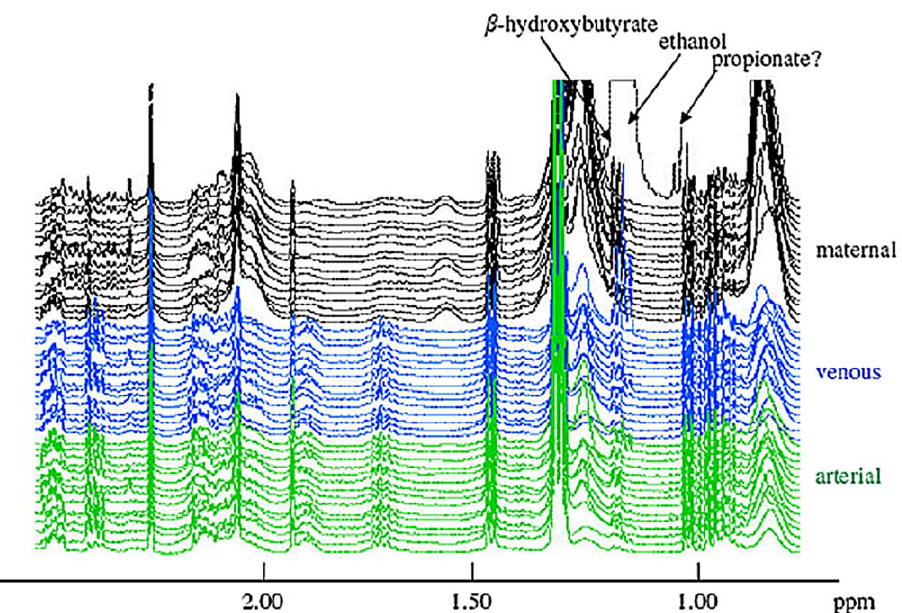
Figure 5. 500 MHz 1 H NMR CPMG spectra of maternal, cord venous and cord arterial plasma. Note the presence of traces ethanol in most spectra and high ethanol and possibly propionate (1.05 ppm) in one unusual maternal profile (the top one). This figure also shows the differences in lipids between maternal and cord plasma (higher levels of lipid signals at 0.90, 1.23, 1.72 and 2.00 ppm) and in lysine levels (signals at 1.71 and 1.90 ppm higher in maternal